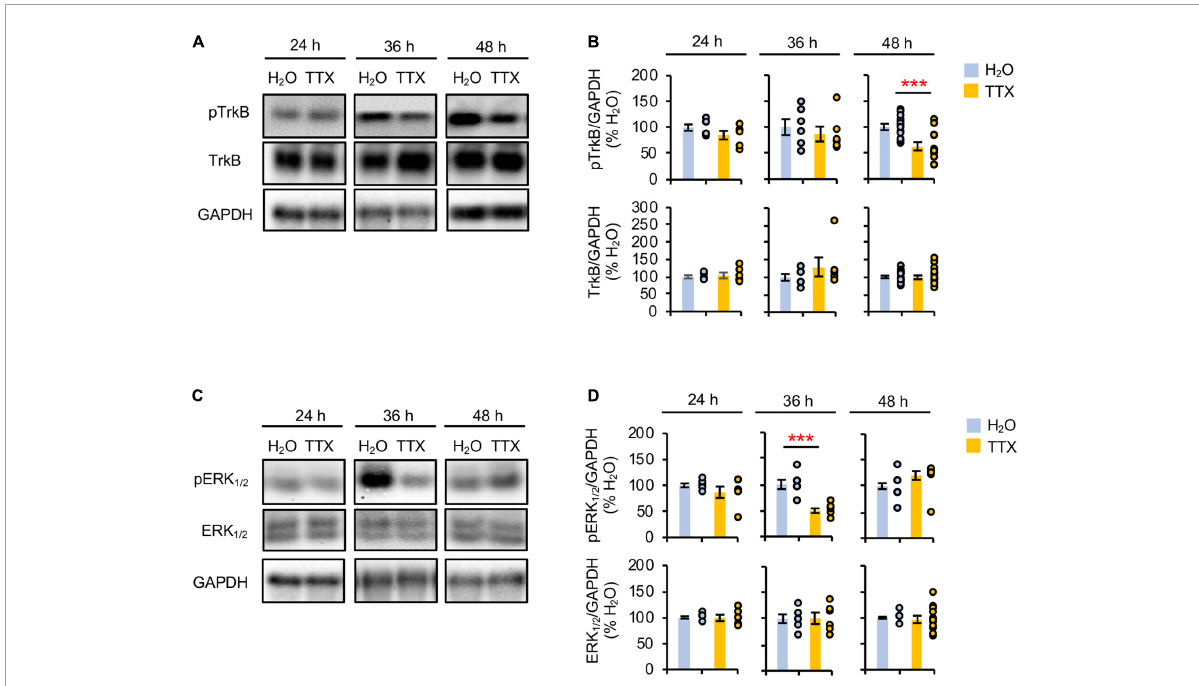
FIGURE1 Prolonged activity blockade transiently reduces ERK1/2 activity before decreasing TrkB activity. Cultured hippocampal neurons (DIV 10) were treated for 24 h, 36 h, and 48 h with TTX (1 µ M) to block their activity or its vehicle control (0.1% H 2 O), and subjected to immunoblot analysis for pTrkB (pTrkA Tyr 674 / 675 / pTrkB Tyr 706 / 707 ) and TrkB (A,B) or pERK 1 / 2 (pERK1 Thr 202 / Tyr 204 /pERK2 Thr 185 / Tyr 187 ) and ERK 1 / 2 (C,D) . GAPDH served as a loading control. (A,B) TTX treatment for 48 h decreased pTrkB level. (A) Representative immunoblots. (B) Quantification of pTrkB and total TrkB immunodensities. The immunodensity ratios (pTrkB/GAPDH and TrkB/GAPDH) were normalized to vehicle control. Number of culture dishes used: pTrkB (24 h: H 2 O = 6, TTX = 6; 36 h: H 2 O = 6, TTX = 6; 48 h: H 2 O = 13, TTX = 13), TrkB (24 h: H 2 O = 6, TTX = 6; 36 h: H 2 O = 6, TTX = 6; 48 h: H 2 O = 17, TTX = 20). (C,D) TTX treatment for 36 h decreased pERK 1 / 2 level. (C) Representative immunoblots. (D) Quantification of pERK 1 / 2 and total ERK 1 / 2 immunodensities. The immunodensity ratios (pERK 1 / 2 /GAPDH and ERK 1 / 2 /GAPDH) were normalized to vehicle control. Number of culture dishes used: pERK 1 / 2 (24 h: H 2 O = 6, TTX = 6; 36 h: H 2 O = 6, TTX = 6; 48 h: H 2 O = 12, TTX = 12), ERK 1 / 2 (24 h: H 2 O = 6, TTX = 6; 36 h: H 2 O = 6, TTX = 6; 48 h: H 2 O = 12, TTX = 12). The Student’s t -test was used (*** p < 0.005). Data shown represent the mean ± SEM with individual data